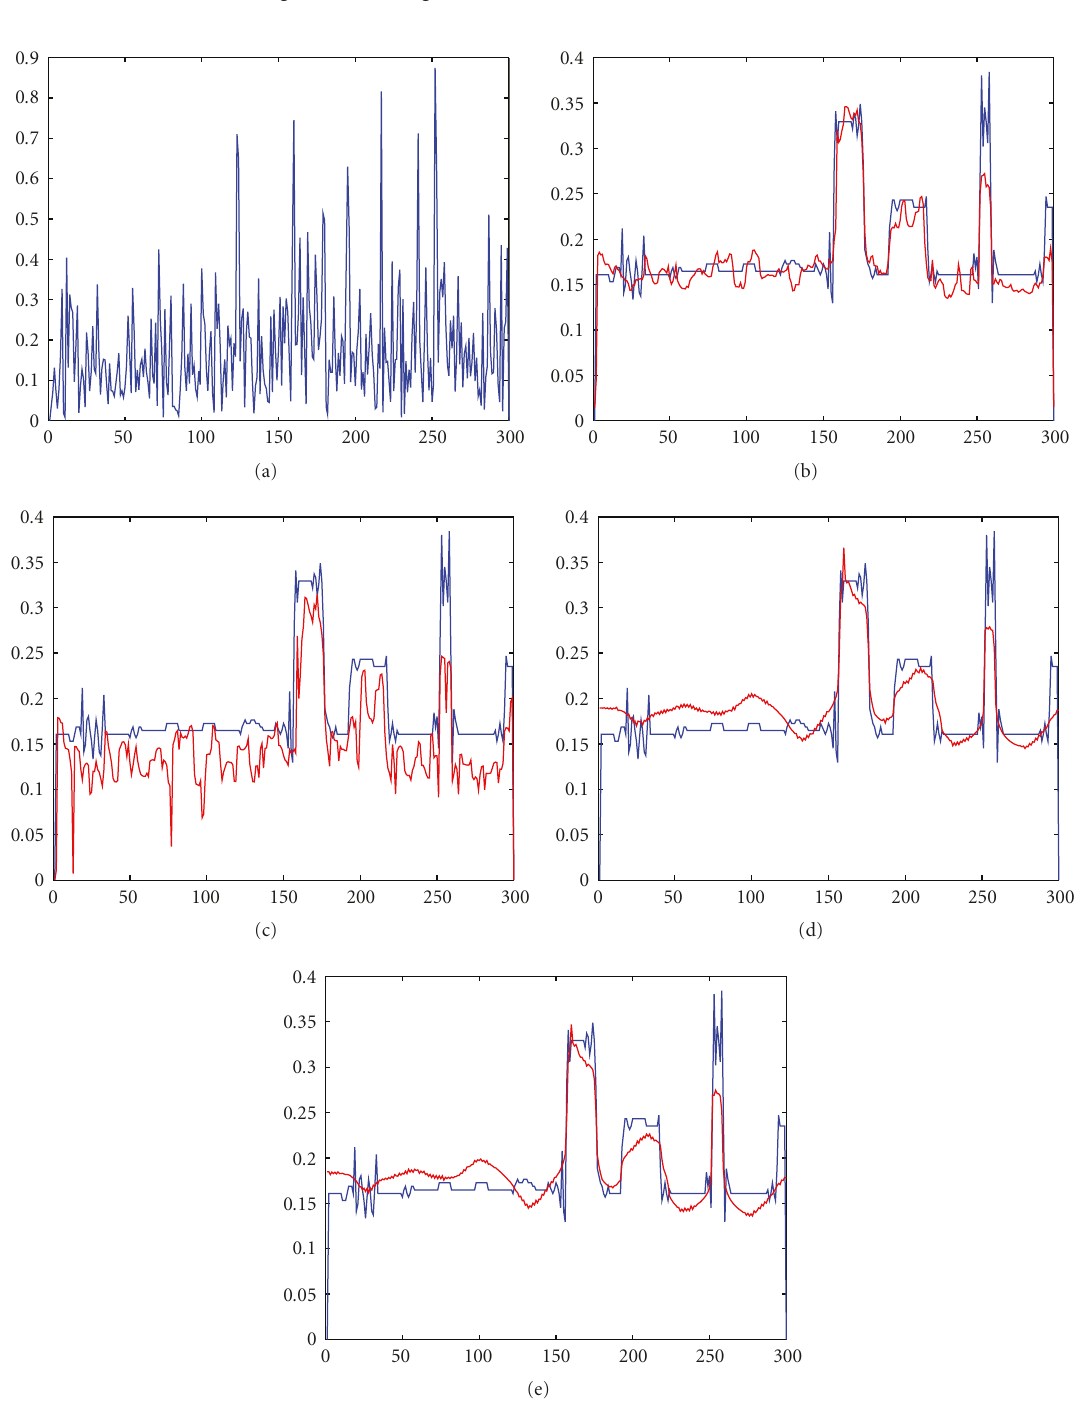
The stopping criterion of the “HMW” method, the “AA” method, and the “RLO” method is that the PSNR value of the restored image reaches its